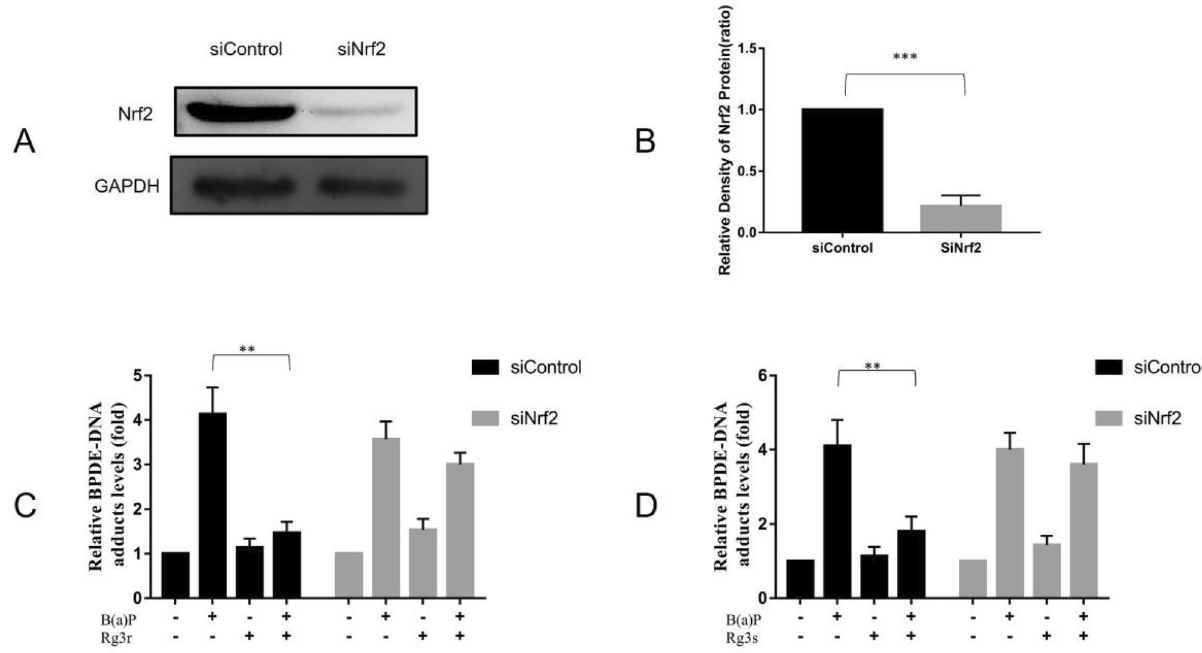
Figure 7. Effect of Nrf2 knockdown on BPDE-DNA adduct formation in hEL cells. ( A ) The knockdown of Nrf2 was confirmed by western blotting. ( B ) Quantification of the Nrf2 band intensity. ( C ) Effect of Nrf2 knockdown on BPDE-DNA adduct levels in hEL cells treated with B(a)P and G-Rg3r. ( D ) Effect of Nrf2 knockdown on BPDE-DNA adduct levels in hEL cells treated with B(a)P and G-Rg3s. The data is presented